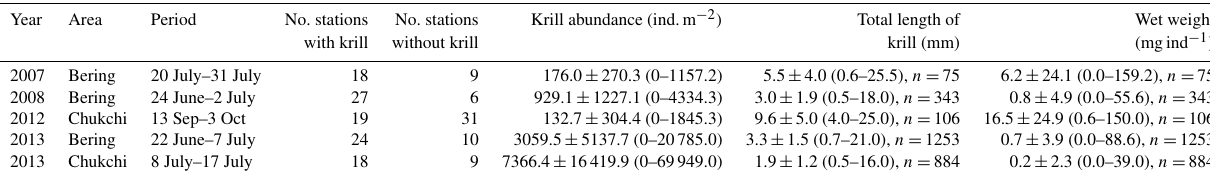
Table 2. Summary of krill surveys showing the abundance, total length, and estimated wet weight of krill in each sampling area. Values are means ± SD (min.– max.), and sample sizes are also